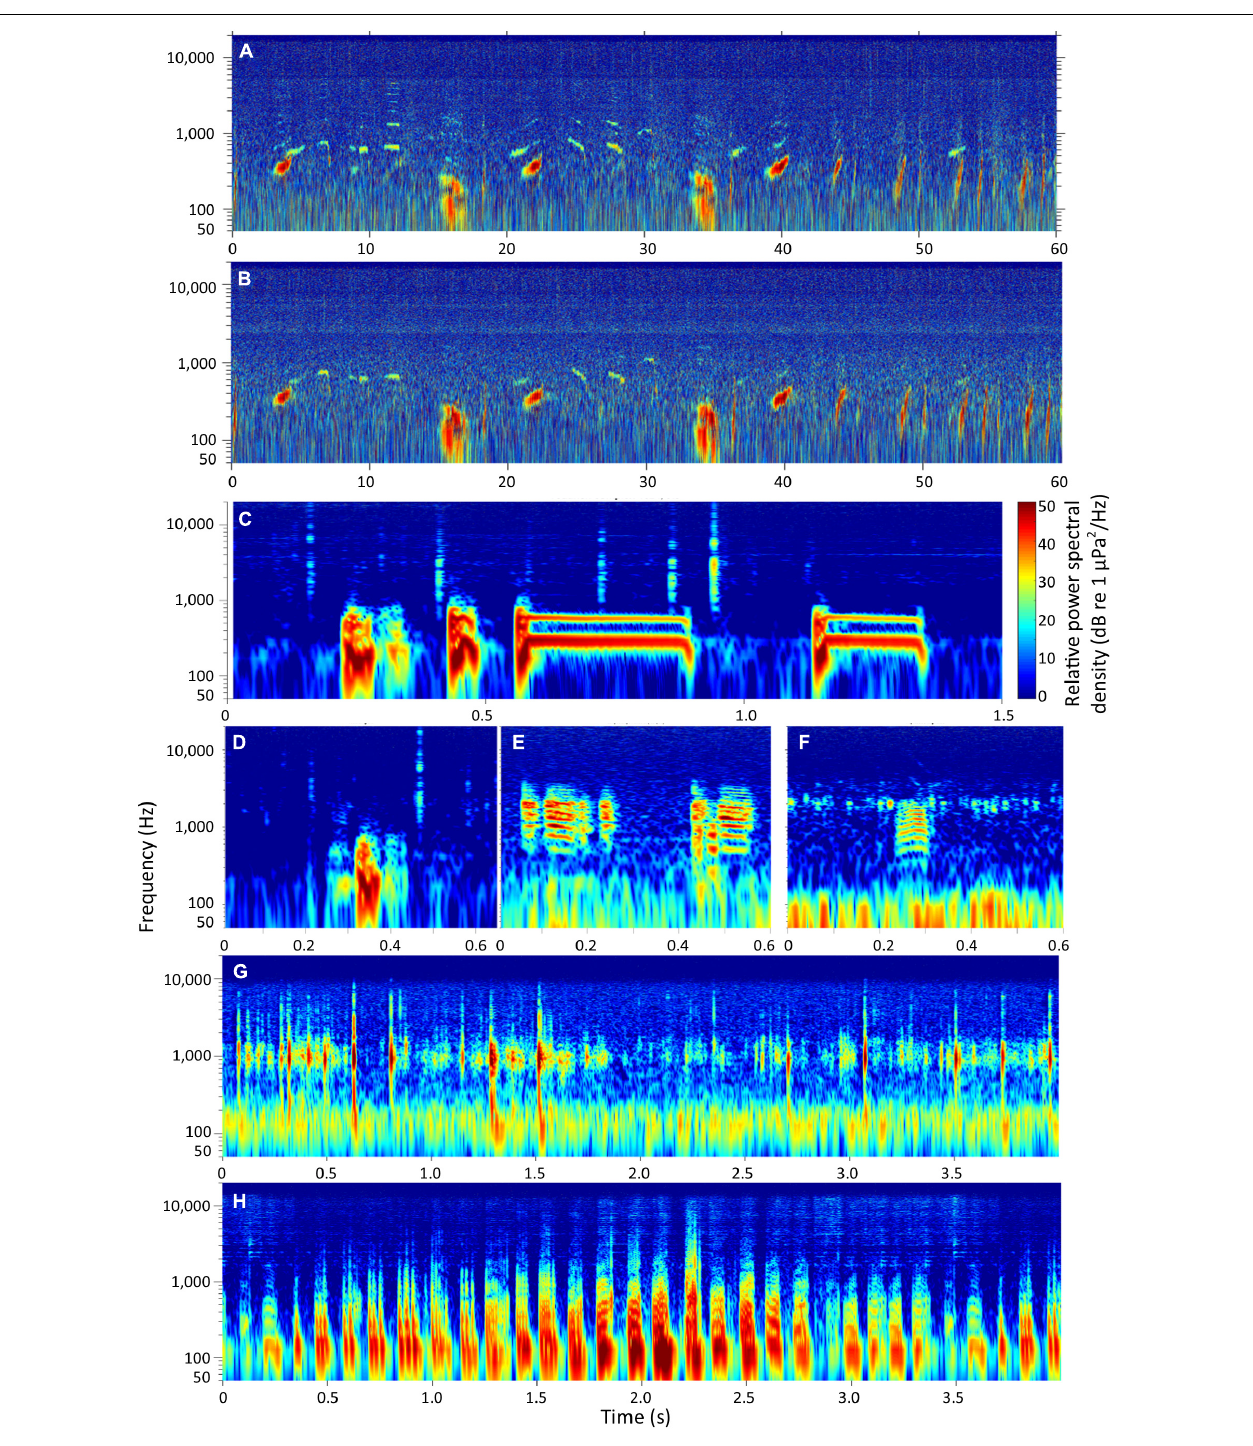
FIGURE 1 | Example spectrograms produced (1,024 point-long Hanning window, 0.9 overlap, frequency display 50–20,000 Hz, relative received levels) from: two simultaneous recordings of a humpback whale ( Megaptera novaeangliae ) song in (A) 20 m and (B) 40 m depth waters off Okinawa, Japan, (recording locations separated by ≈ 500 m, note the lack of high-frequency energy in B ); (C) a complex call and (D) a single grunt sound from gulf toadfish ( Opsanus beta ); (E) two sounds from a 20–30 cm-long sooty grunter ( Hephaestus fuliginosus ); (F) one sound from a 7 cm-long spangled grunter ( Leiopotherapon unicolor ); (G) 4 s of sounds made a crawling kina urchin ( Evechinus chloroticus ) and (H) 4 s of sounds produced by a New Zealand paddle crab ( Ovalipes catharus ). Power spectral density axes in each spectrogram are relative and span 50 dB re 1 µ Pa 2 /Hz. Spectrograms are for comparative purposes and, as such, recording conditions and methods are not provided. All recordings sampled at 44.1 ksps except that producing panel (E) , which was sampled at 48 ksps.